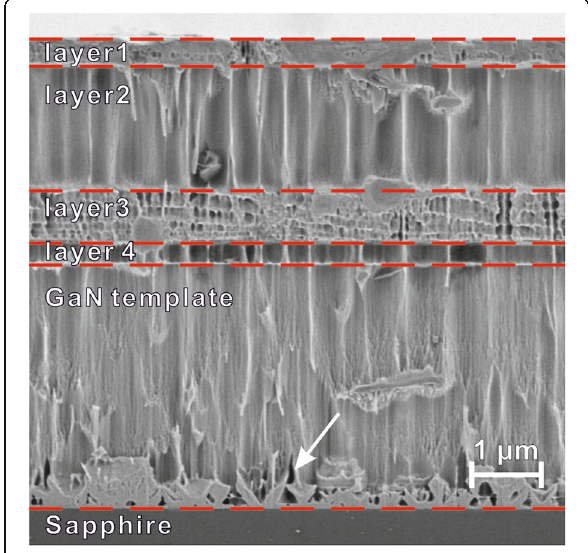
Fig. 2 SEM image of cross-section of the investigated n + /n 0 /n + -GaN structure. The irregular pattern of vertical lines was formed during cleaving (i.e., before photo-etching) and is characteristic for the non- polished cleavages of Al 2 O 3 /GaN hetero-structures. Rough pyramidal layer ( pinholes ) at the sapphire/GaN template indicated by the arrow was revealed by photo-etching